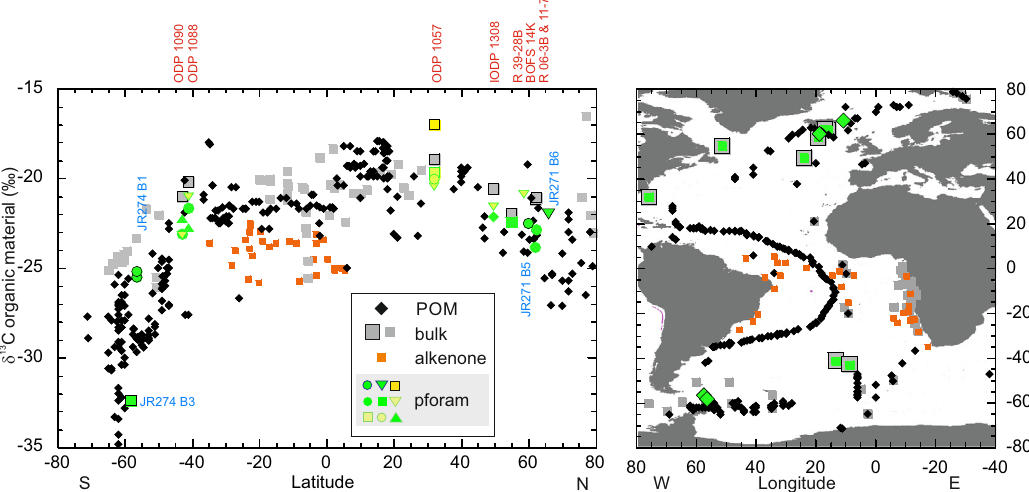
Fig. 1 | Main results. Right: sample locations of surface water δ 13 C org-POM (black diamonds 45 ), bulk sediments (grey squares 20,28,48 – 51 ), alkenone δ 13 C (orange squares 52 )andplanktonicforaminifera δ 13 C org (greendiamondsplanktonnet;green squarescoretops).Coretopalkenone δ 13 CarerestrictedtotheSouthAtlantic;data from areas characterized by lateral transport (e.g. ref. 56) are not included. Left: δ 13 C org of surface water particulate organic matter (POM, black diamonds), sedi- mentary organic matter (grey squares; grey squares with black border, this study),